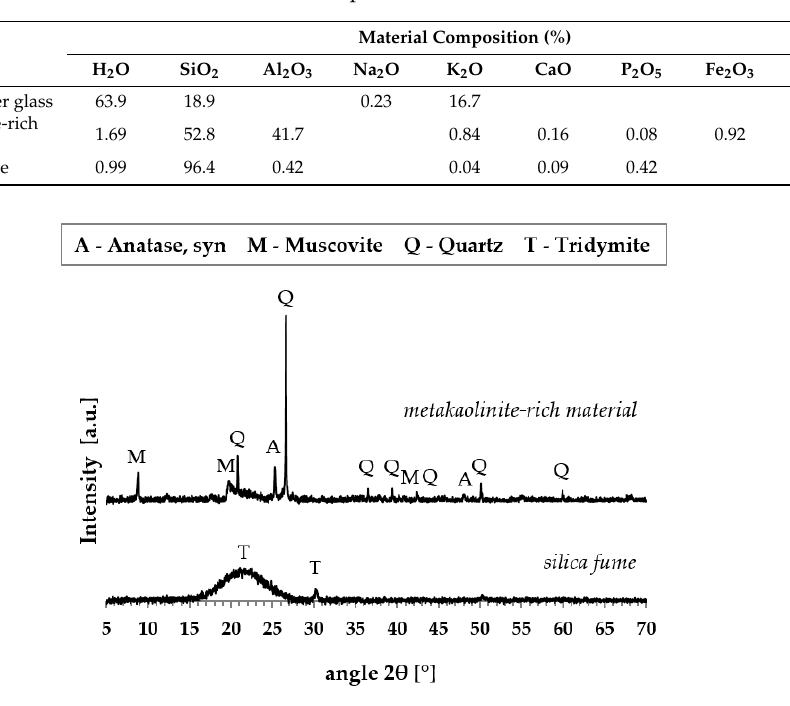
Figure 1. X-ray powder diffraction analysis of metakaolinite-rich and silica material.